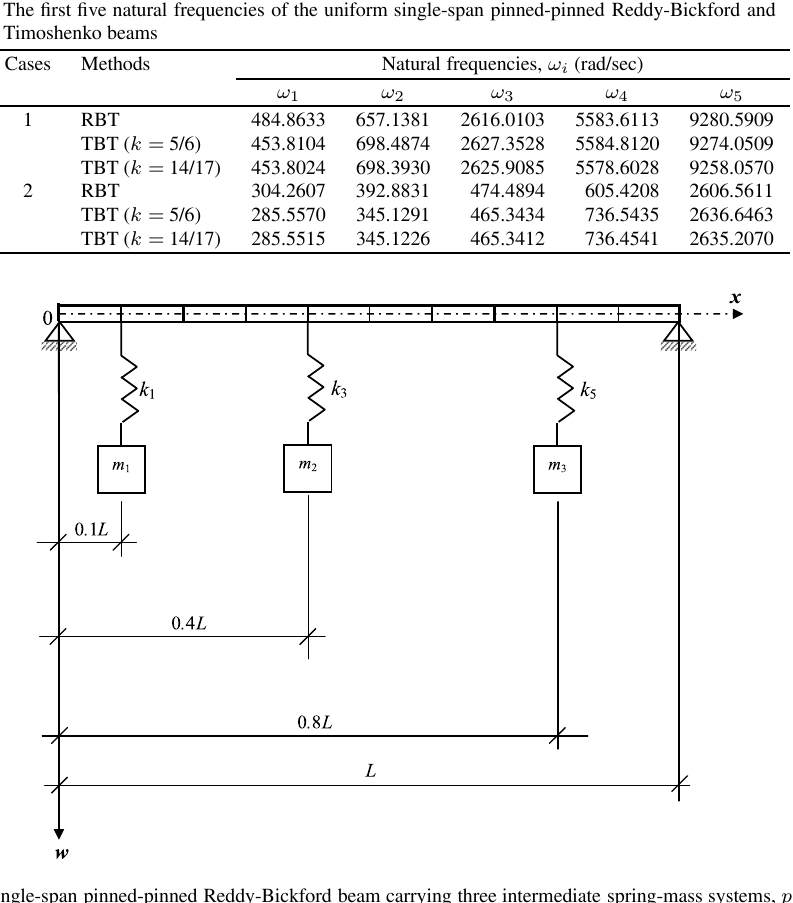
Fig. 3. A single-span pinned-pinned Reddy-Bickford beam carrying three intermediate spring-mass systems, p = 1 to 3. 4.1. Free vibration analysis of the uniform single-span pinned-pinned Reddy- Bickford beam carrying